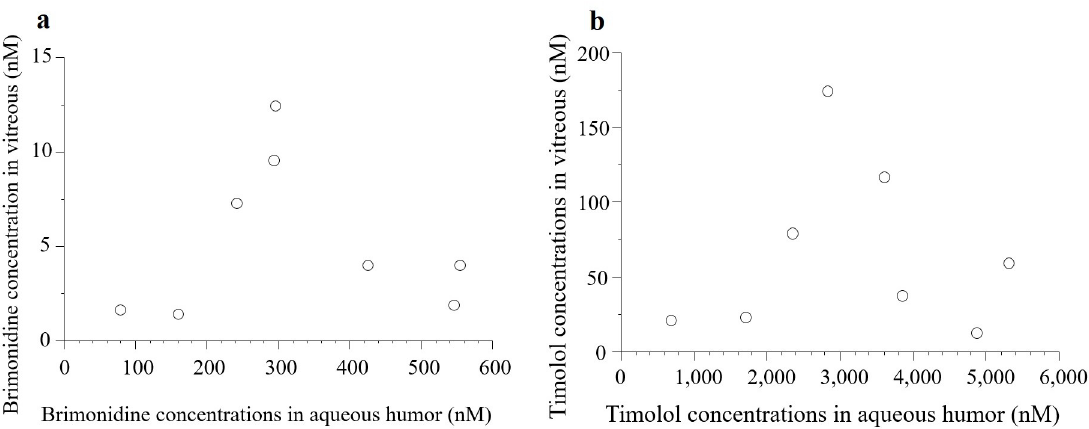
Fig 3. Correlations between drug concentrations in the aqueous and vitreous humors. There was no significant correlation of the brimonidine (a) and the timolol (b) concentrations between in the aqueous humor and the vitreous.